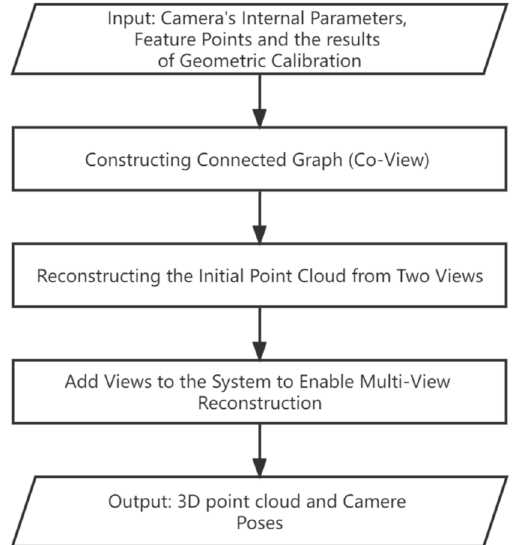
Figure 7. The steps of the SfM provided by OpenMVG for 3D